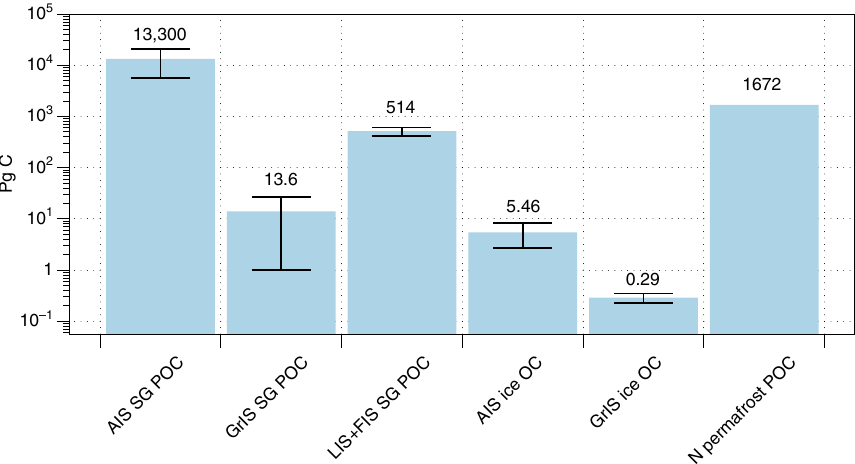
Fig. 3 Carbon inventories for present day and former ice sheets. Data presented includes minimum, mid-range and maximum estimates. Antarctic Subglacial POC (AIS SG POC), minimum estimates are calculated assuming a sediment depth of 1 km, sedimentary basin areas of 1 × 10 6 km 2 for WAIS and 2.5 × 10 6 km 2 for EAIS, a rock density of 2650kg m -3 , a porosity of 0.3 and a POC of 0.1% 169 , maximum estimates are derived from ref. 169 . and mid-range values as the average between the two, Greenland Ice Sheet Subglacial POC (GrIS SG POC, minimum estimates calculated assuming a POC of c. 0.2% 170 , sediment thicknesses of 0.1 m 171 and a porosity of 0.4 172 , maximum estimates assuming a POC of 0.44% 36 , sediment thicknesses of 2 m 171 and a porosity of 0.3 172 and mid-range values as the average between the two), Laurentide + Fennoscandian Ice Sheet Subglacial POC (LIS + FIS SG POC, minimum, maximum and mid-range estimates from ref. 18 ), Antarctic Ice Sheet englacial POC + DOC (AIS ice OC, mid-range, minimum and maximum values from ref. 9 , where the min/max values only include DOC due to lack of data), Greenland Ice Sheet ice-bound POC + DOC (GrIS ice OC, mid-range, minimum and maximum values from ref. 9 , where the min/max values only include DOC due to lack of data) and Northern hemisphere permafrost (N